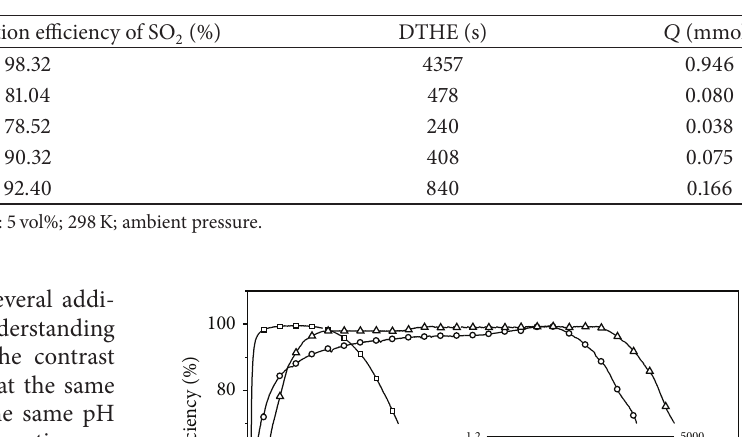
Table 2: The SO absorption using different absorption solution a . 2